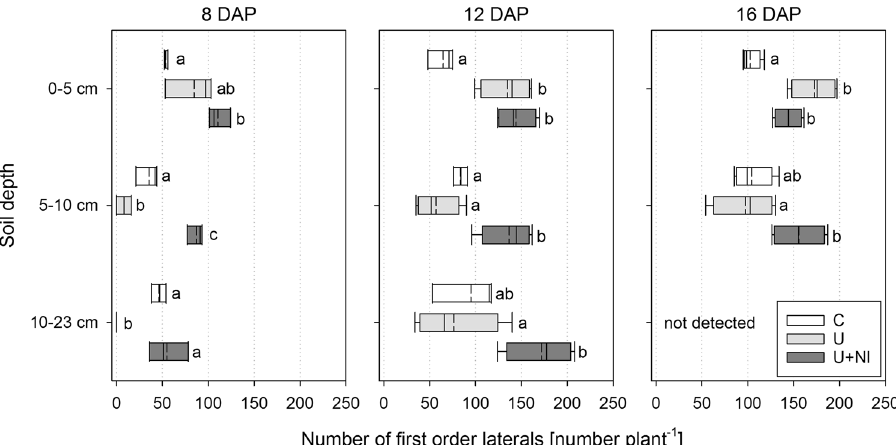
Figure 10. Number of first order lateral roots of Hordeum vulgare plants for treatments control (“C”), urea (“U”) and urea with nitrification inhibitor (“U+NI”), separated for three depths for each harvest. Top layer (0–5 cm) is above fertiliser zone, bottom layer (10–23 cm) is below fertiliser zone. Statistical comparison is performed for number of first order laterals per layer between treatments. Significant differences ( p < 0.05) are indicated by different letters. Bottom layer at 16 DAP was too complex for a reliable analysis; dashed lines in the boxplots represent mean values while solid lines represent the